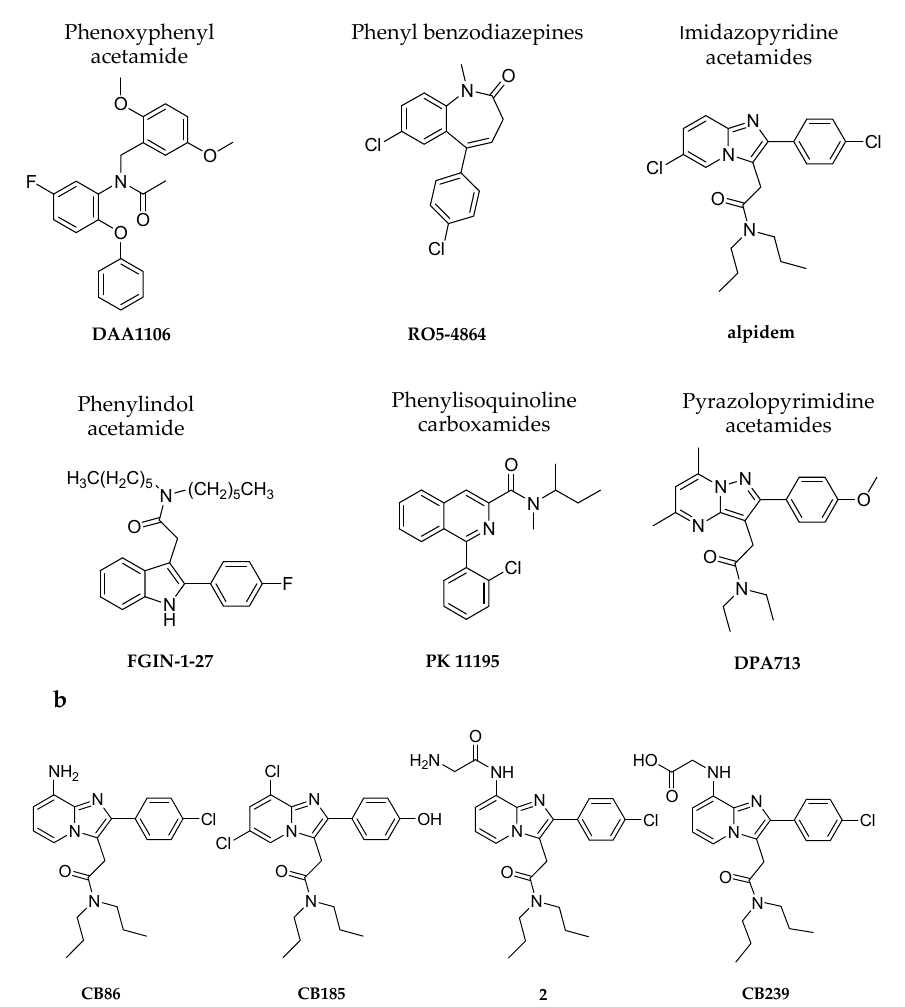
Figure 1. Chemical structures of the typical synthetic TSPO ligands presented in structural classes ( a ); and selective TSPO ligands with hydrophilic substituents ( b ).